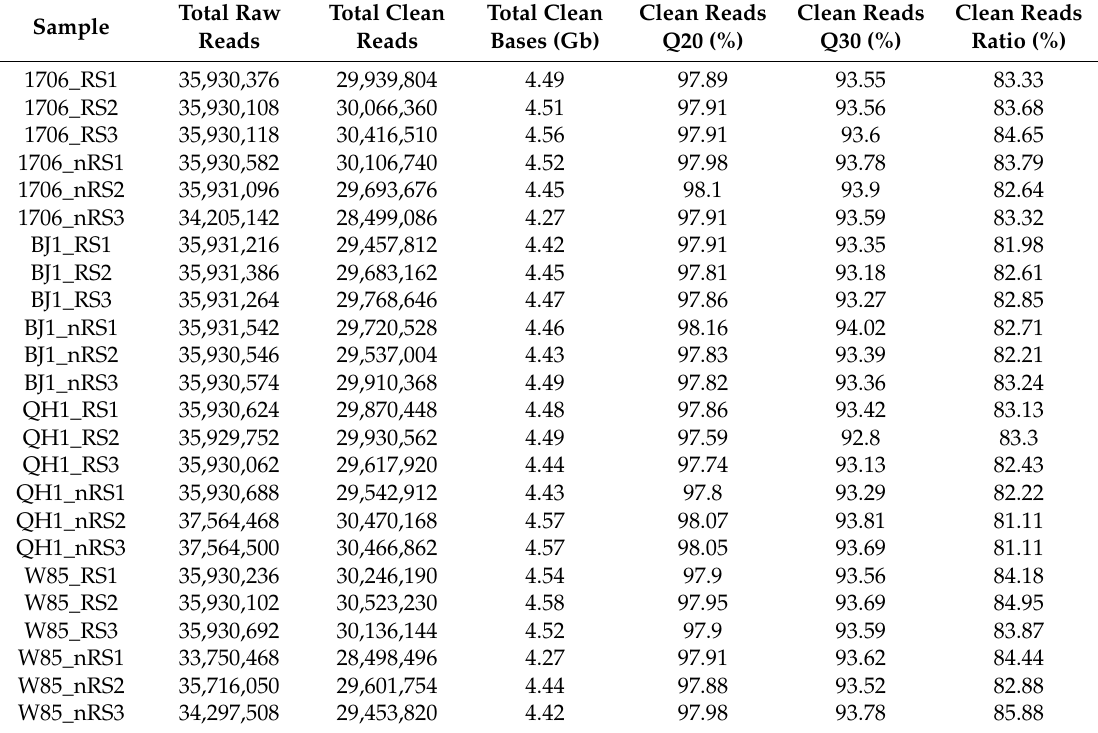
Table 1. Summary of the sequencing data from different R. glutinosa